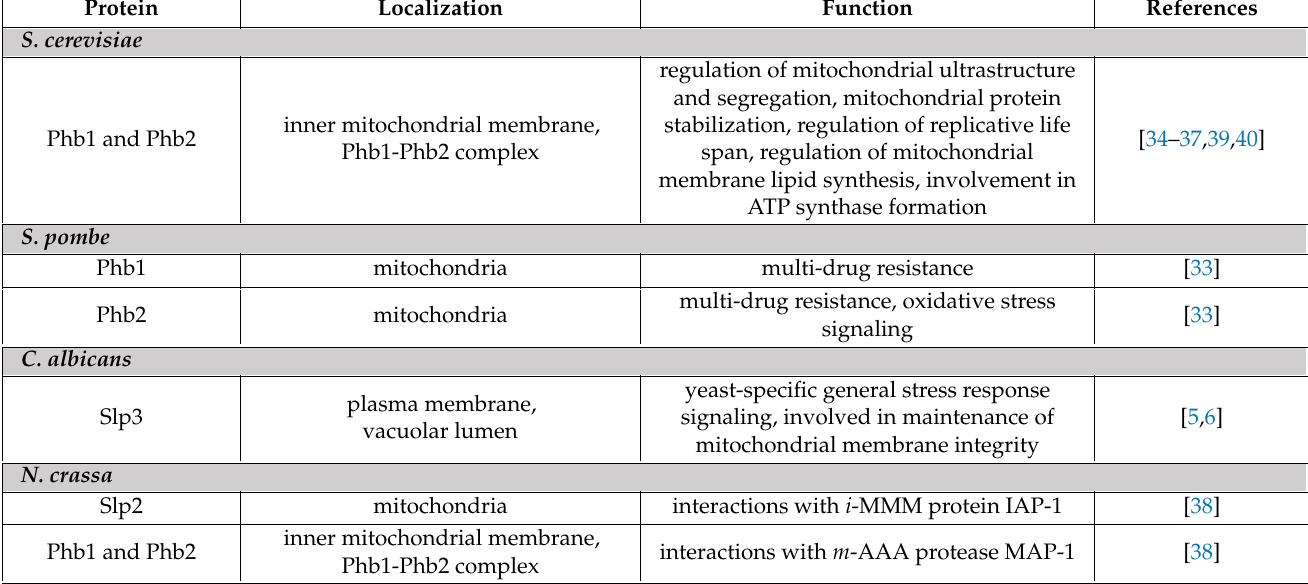
Table 1. SPFH proteins with known functions in fungi. SPFH protein localization and function for each fungal species listed have been experimentally confirmed in the referenced literature .